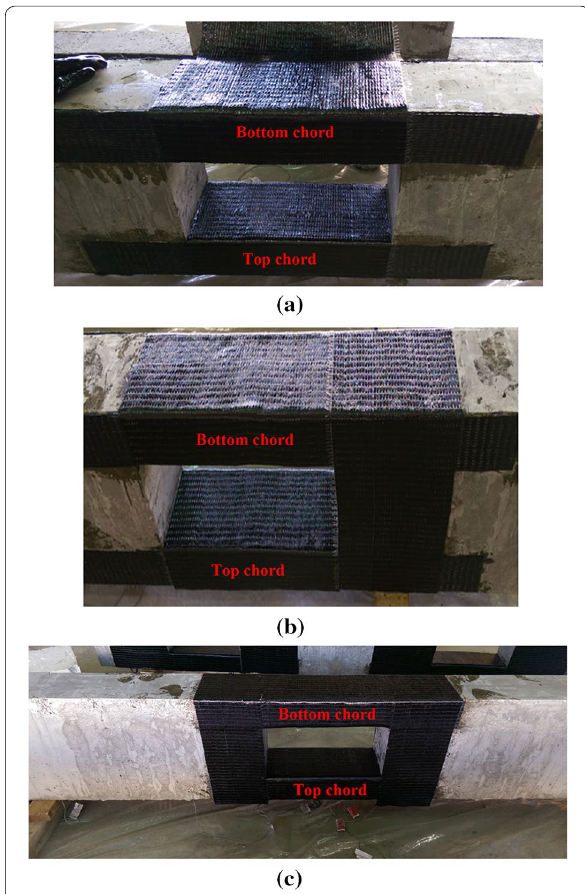
Fig. 5 Steps involved in strengthening of beam BS1‑O1‑CPL using scheme‑1: a 1st CFRP layer is completed on both chords, 2nd layer of CFRP U‑wrap is completed for top chord, and bottom chord is being fully wrapped with 2nd CFRP layer, b 2nd layer of CFRP U‑wrap is completed on one opening side, and c strengthened beam ready for